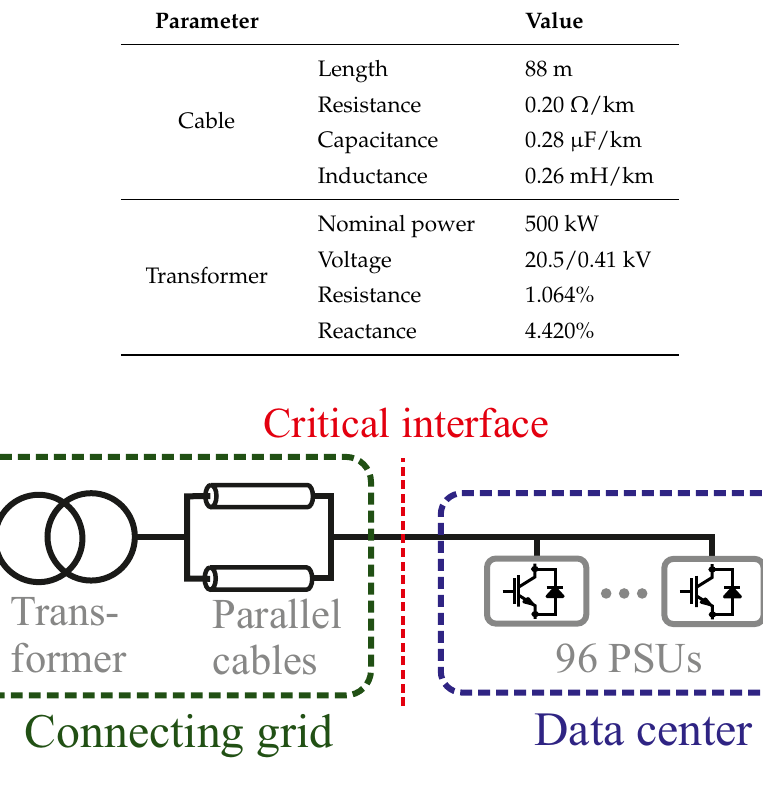
Figure 6. Schematic diagram of the data center and the